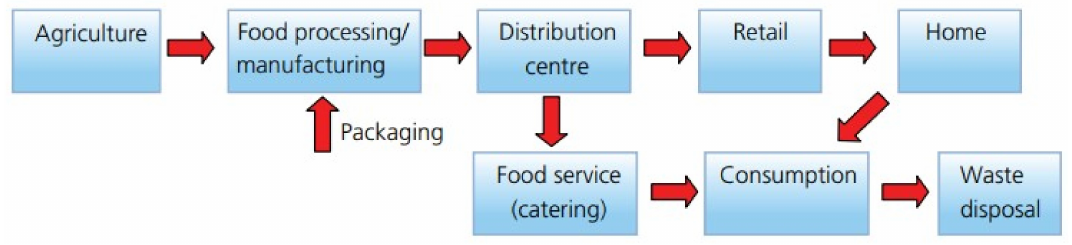
Figure 1. Schematic of main stages in the food chain